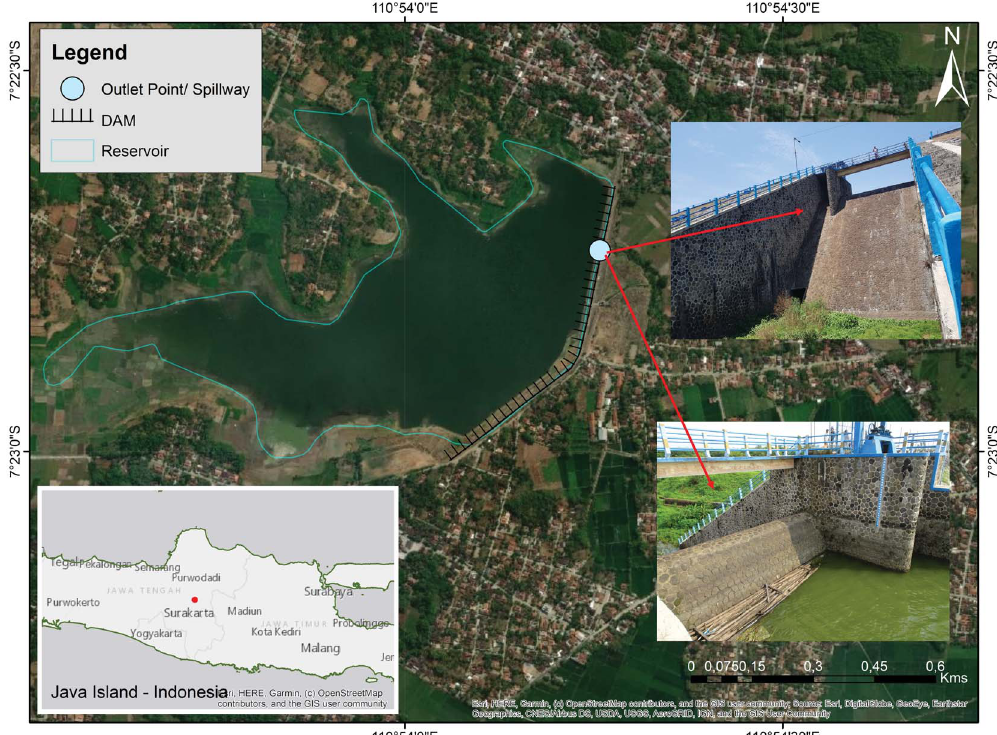
Figure 1. Location of Ketro Dam.